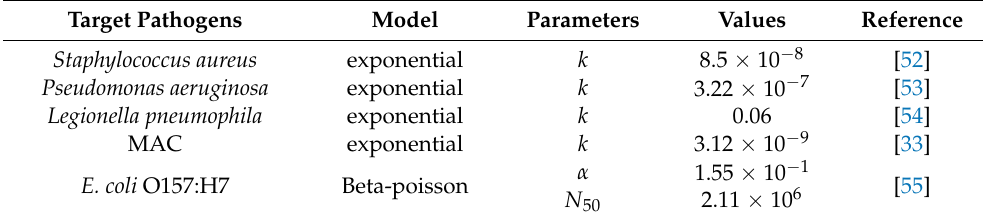
Table 3. Pathogen